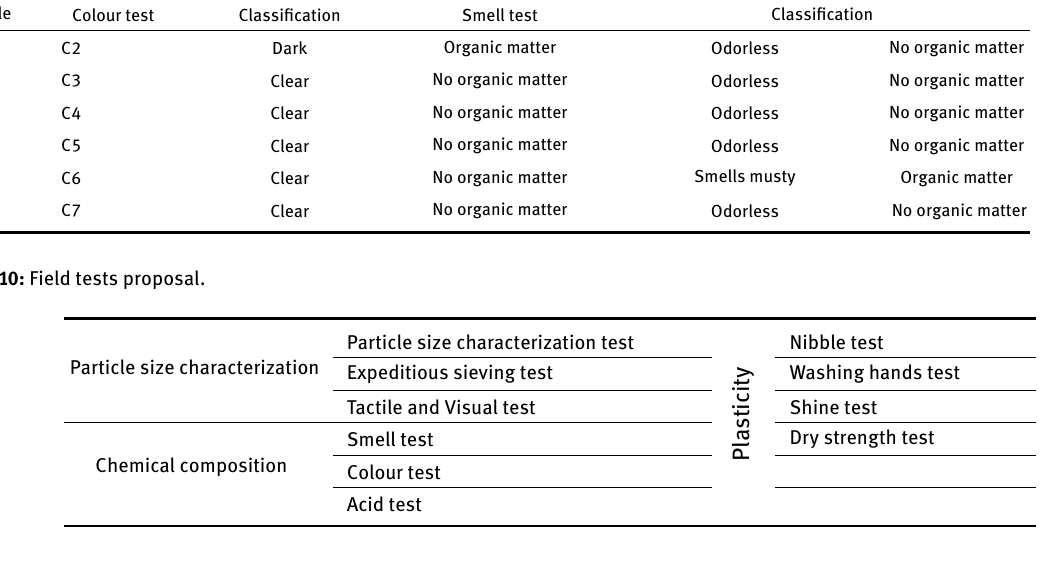
Table 9: Colour and smell test results. Sample